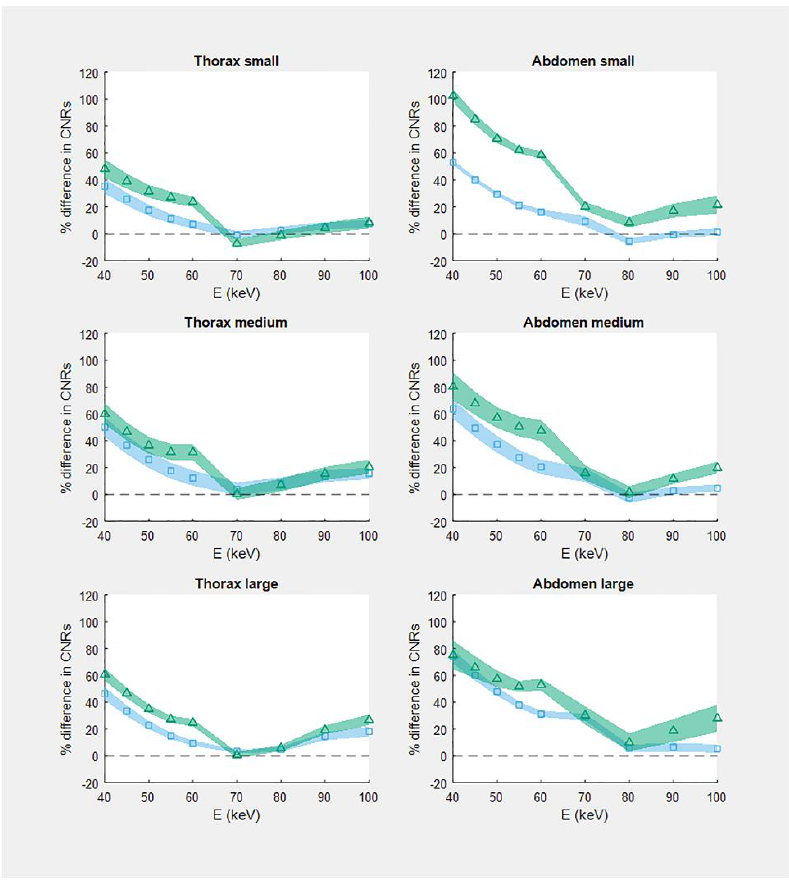
Figure A2. Relative CNR in virtual monoenergetic images reconstructed with iterative reconstruction (IR) technique as a function of energy E (keV). For each phantom and energy, CNR of the PCD-based system (with 75% IR strength) is presented relative to the CNR of the EID-based system (with 60% IR strength). Squares: single-energy 120 kVp PCD-CT. Triangles: single-energy 90 kVp PCD-CT. Symbols depict the estimated value and the accompanying shaded boundaries depict the standard error of this estimate.